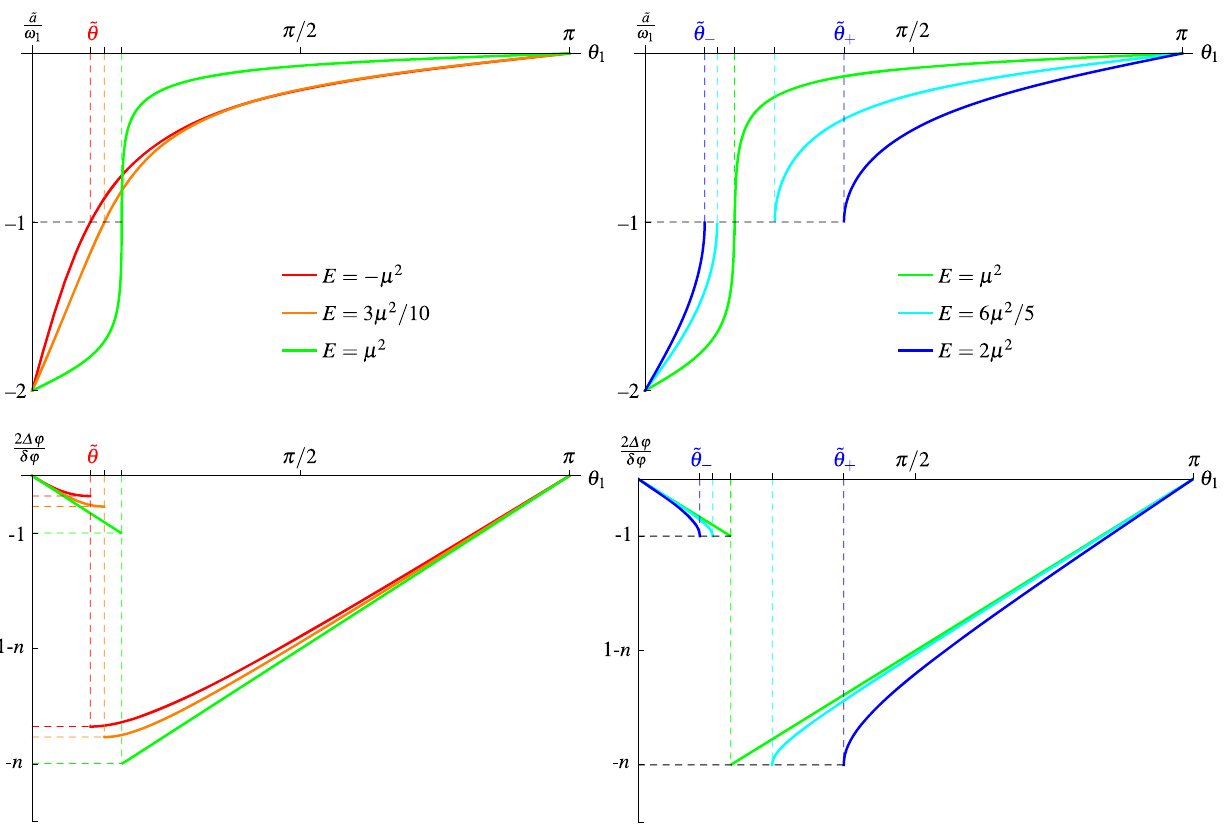
Fig. 11 The parameters ˜ a and Δϕ , which determine the asymptotic behaviour of the dressed solutions, as functions of the angle θ 1 . The parameter a of the seed elliptic solution is selected so that the latter obeys appropriate periodicity conditions with n =